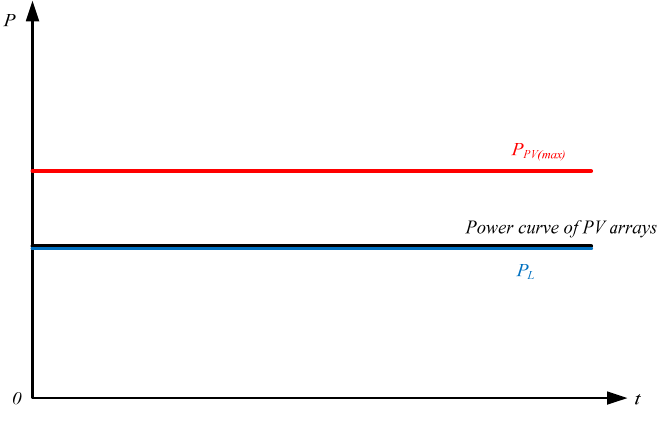
Figure 9. Plot of power curve of the proposed PV power system under operational mode VI.